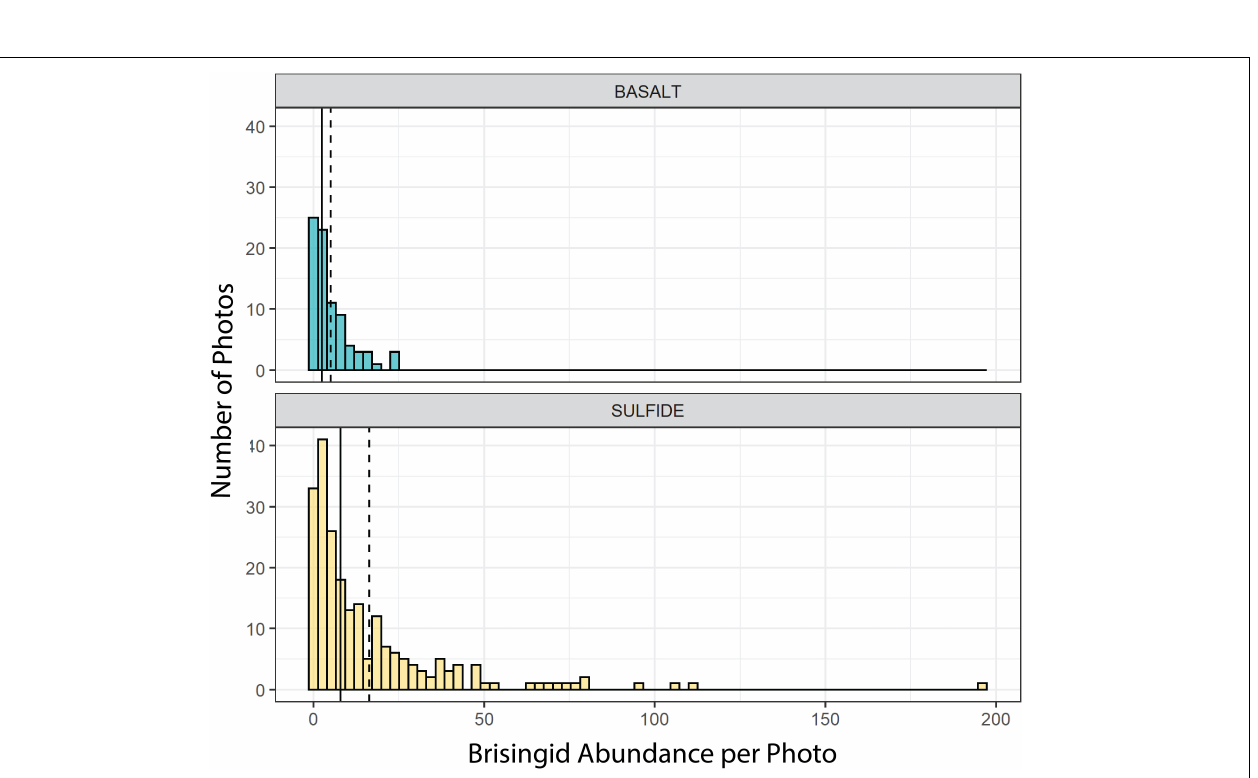
Frontiers in Marine Science |